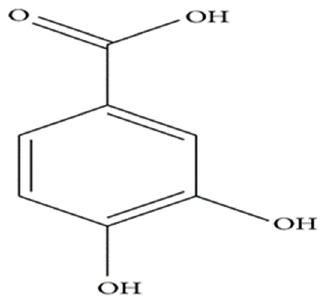
Figure 1. Chemical Structure of protocatechuic acid.